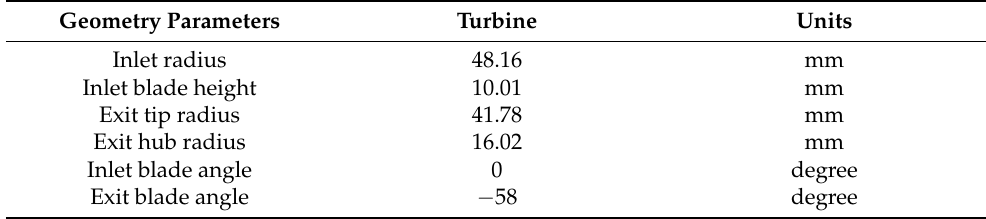
Table 1. Detailed geometry of turbine.